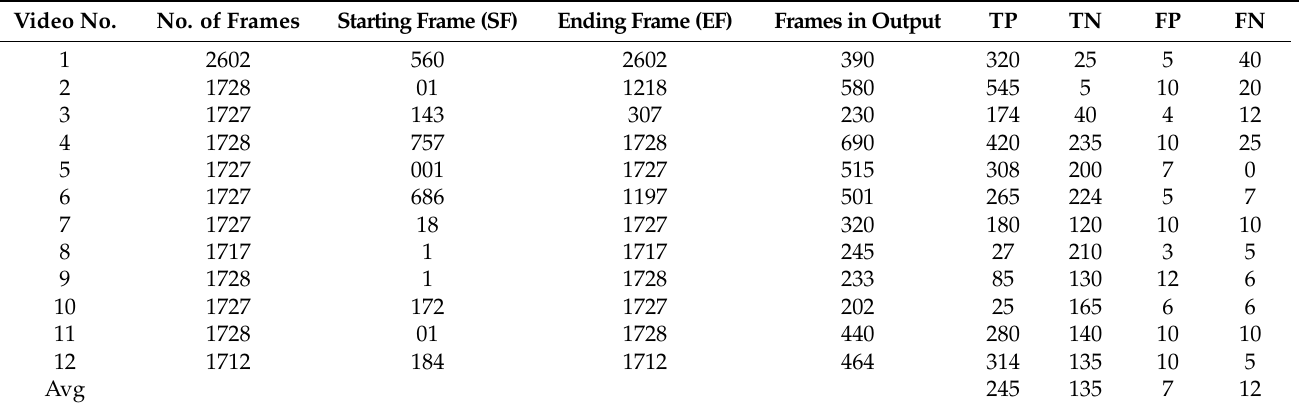
Table 4. Detailed analysis of Table 4 Detailed analysis of videos.